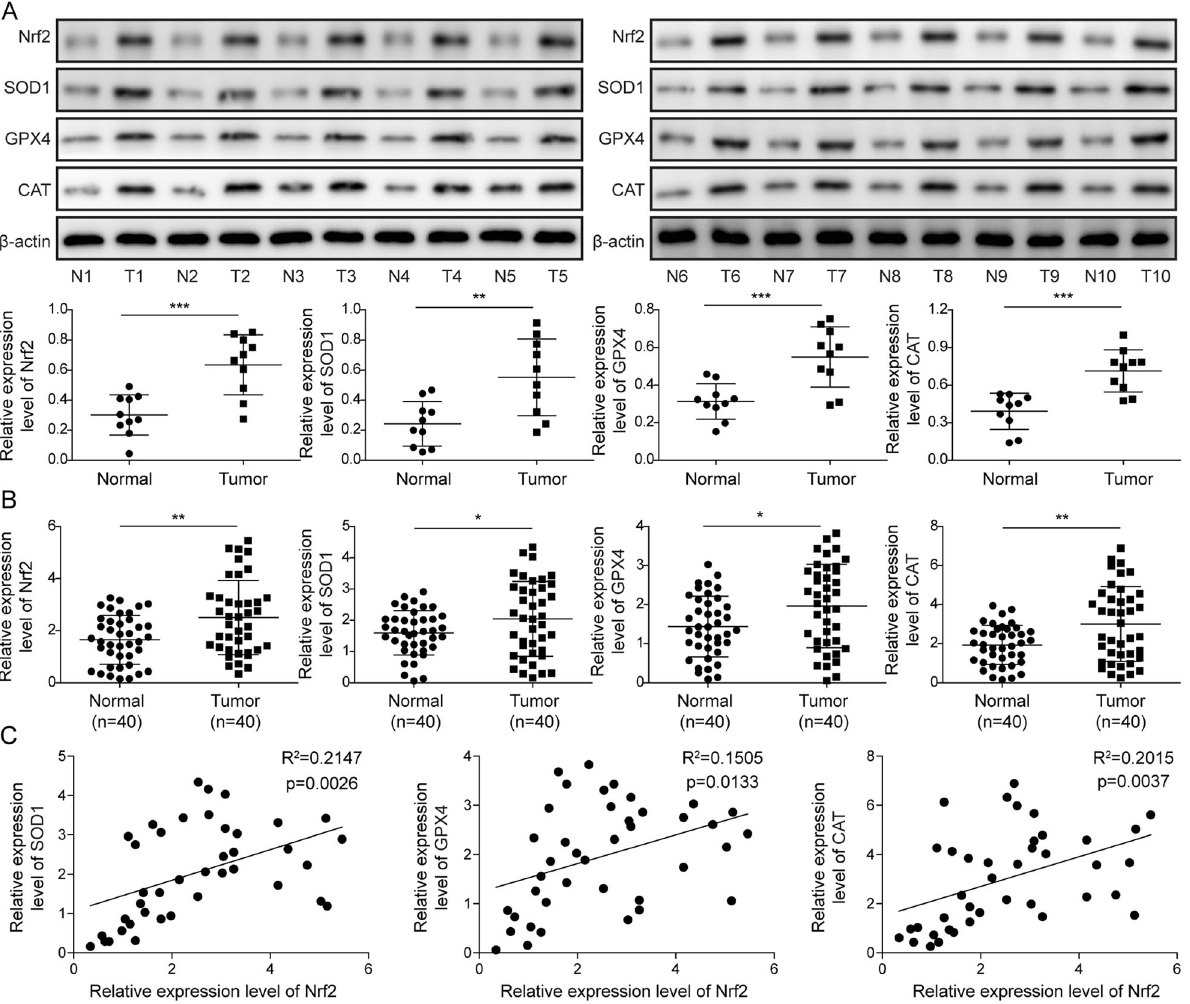
Fig. 1 Increased NRF2 expression level is positively correlated to CRC progress. A The expressions of Nrf2, SOD1, GPX4, and CAT in tumor tissues and adjacent tissues from 10 CRC patients detected by western blot. B The expressions of Nrf2, SOD1, GPX4, and CAT in tumor tissues and adjacent tissues from 40 CRC patients detected by RT-qPCR. C The Pearson correlation analysis of Nrf2 with SOD1, CAT, and GPX4. All experiments were carried out at least three times, n = 3, * P < 0.05 and ** P <